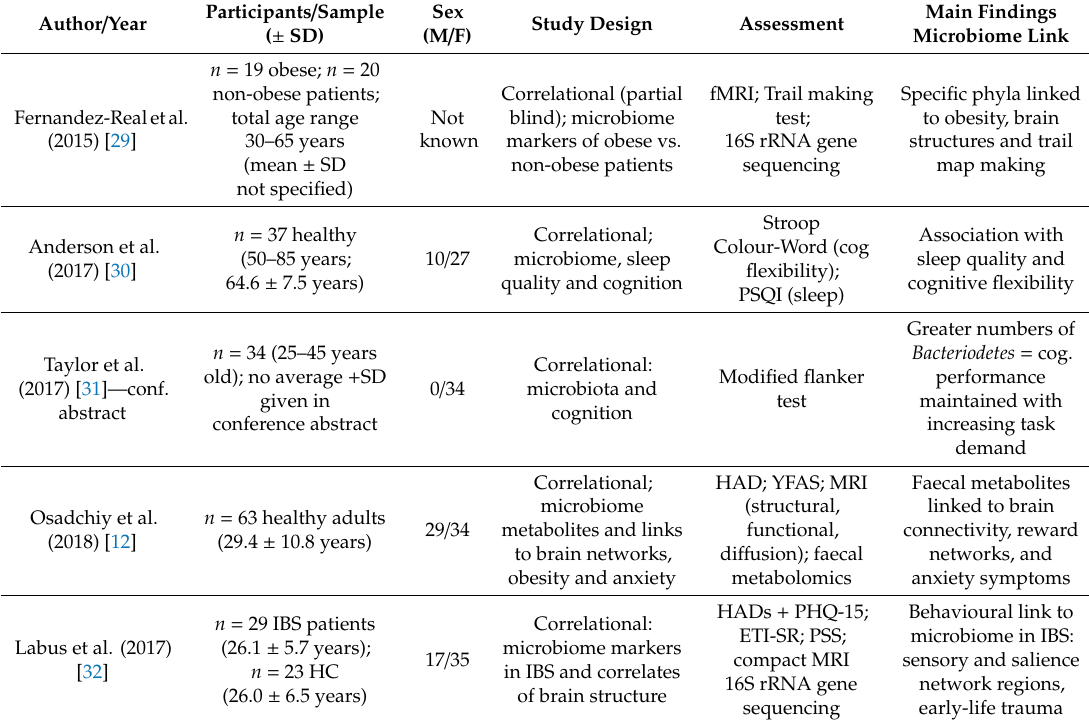
Table 2. Exploratory human studies describing correlations / interactions between the gut microbiota and cognition, brain structure or function (no